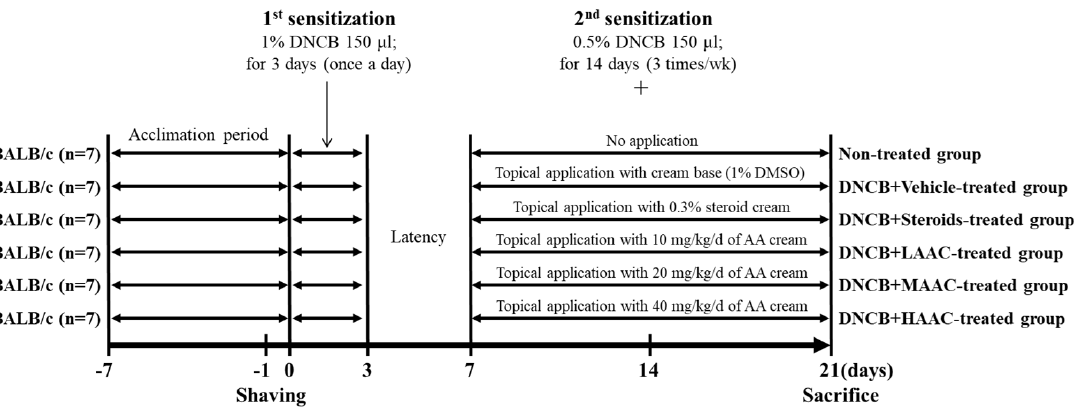
Figure 14. Experimental scheme for AAC spreading onto the skin of DNCB-treated BALB/c mice. Abbreviations: AAC, Abietic acid cream; DNCB, 2,4-Dinitrochlorobenzene.